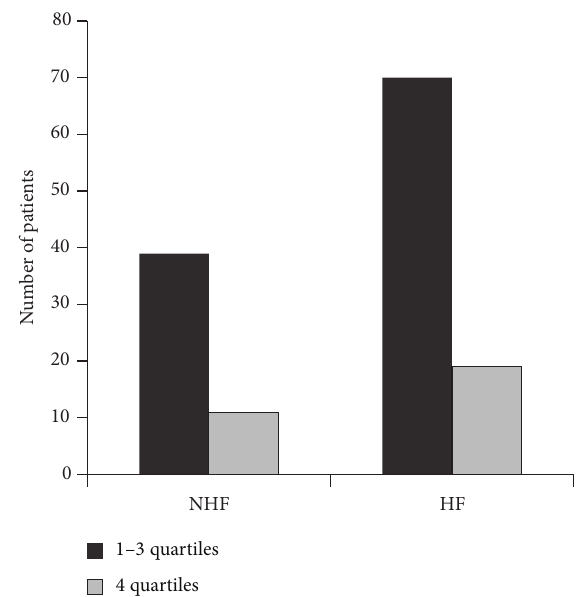
Figure 3: Number of patients within the 4th quartile against the other three quartiles in the group with (HF) and without heart failure (NHF). HF: heart failure, NHF: without heart failure, LV: left ventricle, and A: